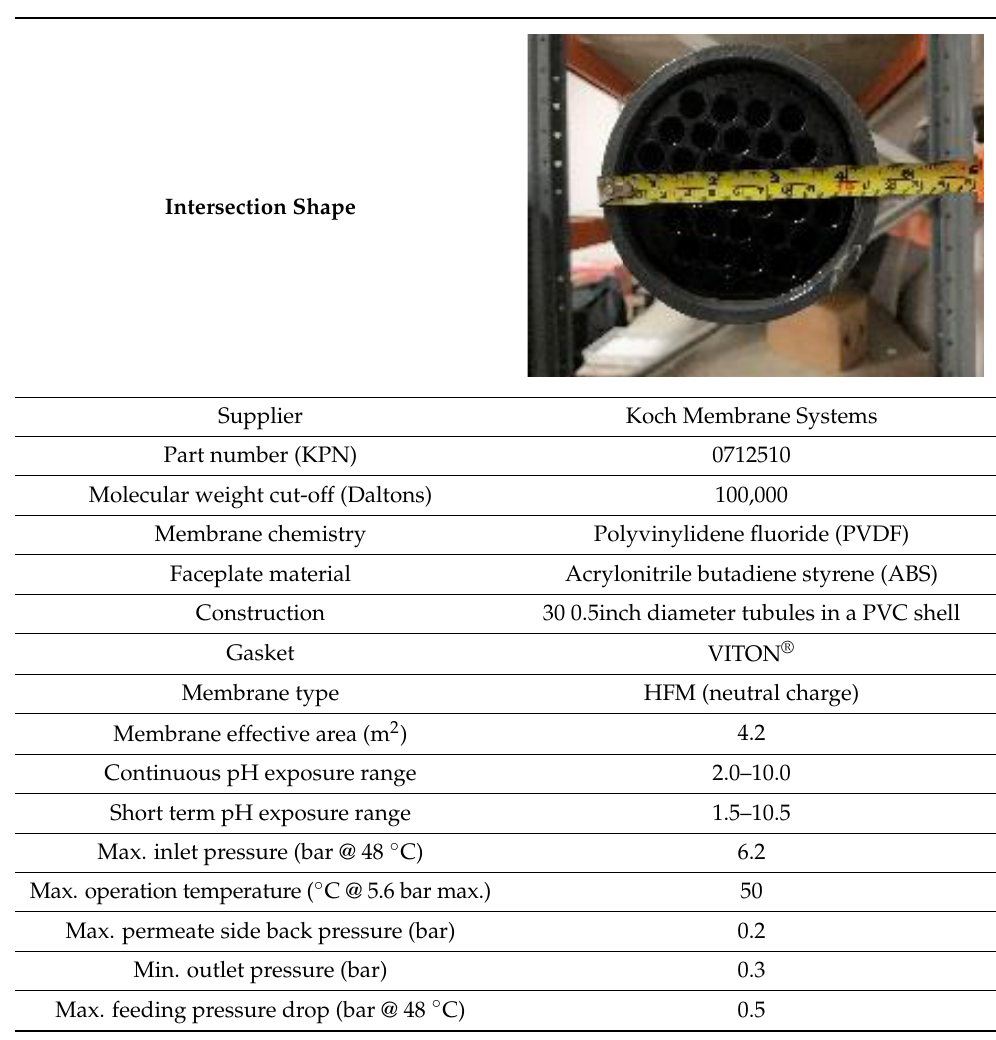
Table 1. Characteristics of the ABCOR ® -INDUCOR module used in this study.